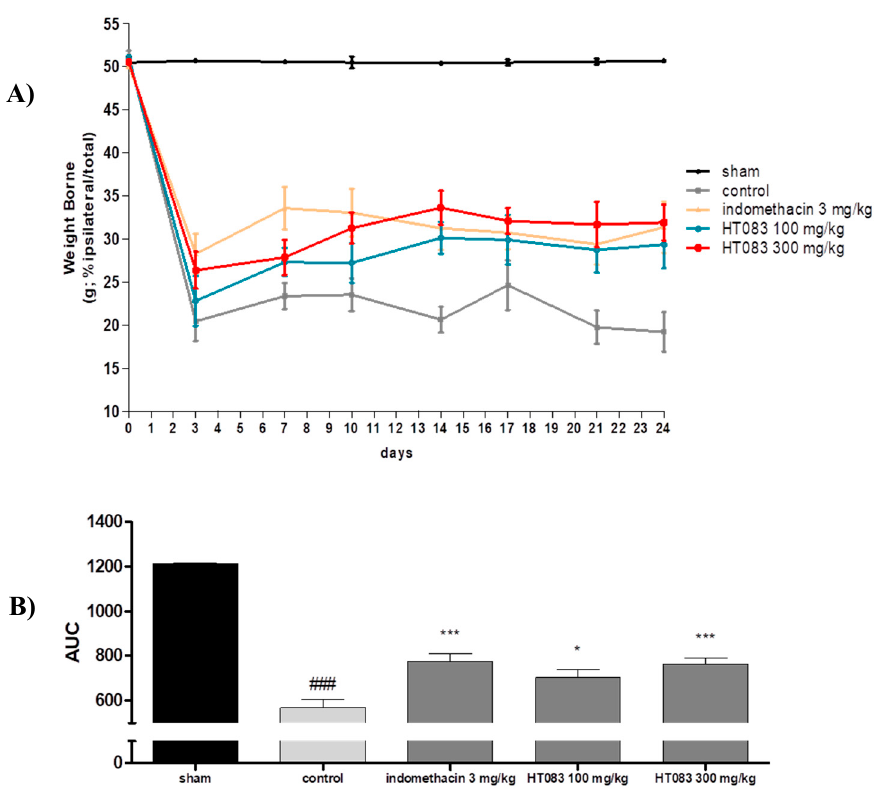
Figure 2. Effects of HT083 on the change of weight-bearing in rats injected with monoiodoacetate (MIA). ( A ) Distribution ratio of right and left hind-limb weight-bearing of the MIA rats after 24 days of MIA injection. The positive control (PC) was indomethacin (10 mg / kg). ( B ) AUC, area under the curve; evaluated the right and left hind-limb weight-bearing in MIA rats after 24 days of MIA injection. The values were expressed as the mean ± S.E.M. ( n = 9). ### p < 0.001 vs sham, * p < 0.05, and *** p < 0.001 vs control.